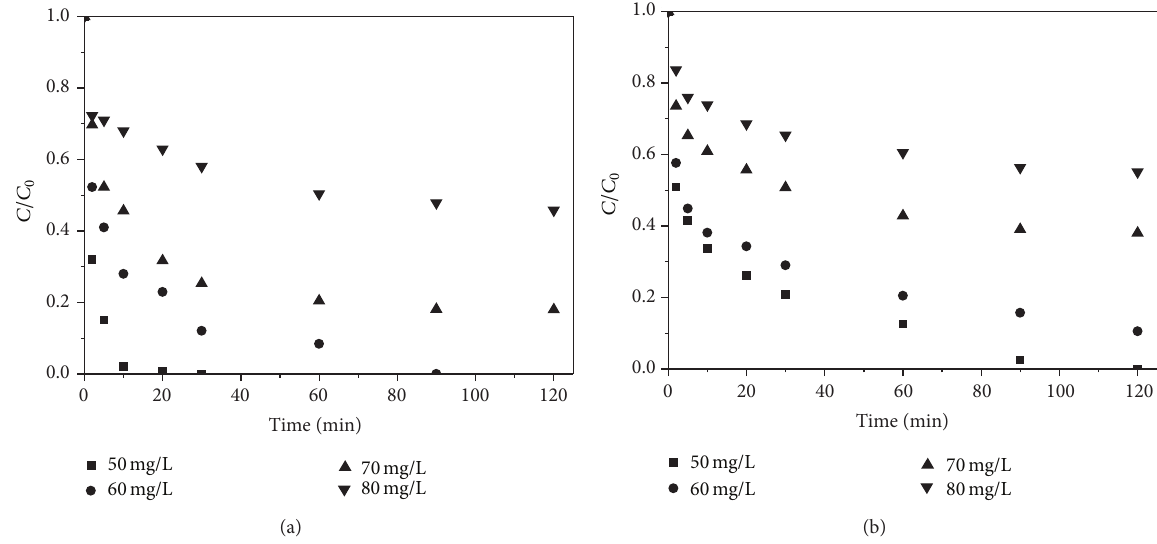
Figure 5: Effect of initial metal ion concentration on Cr(VI) (a) and Cd(II) (b) removal by Fe@SiO 2 . Fe dose: 0.15 g ⋅ L −1 , pH: 6.0 ± 0.1 , and temperature: 25 ∘